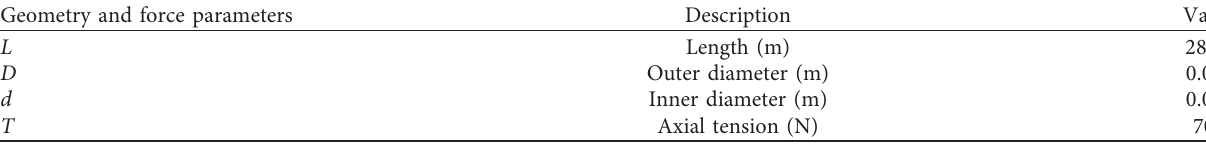
Table 1: Values for geometry parameters of the marine viscoelastic